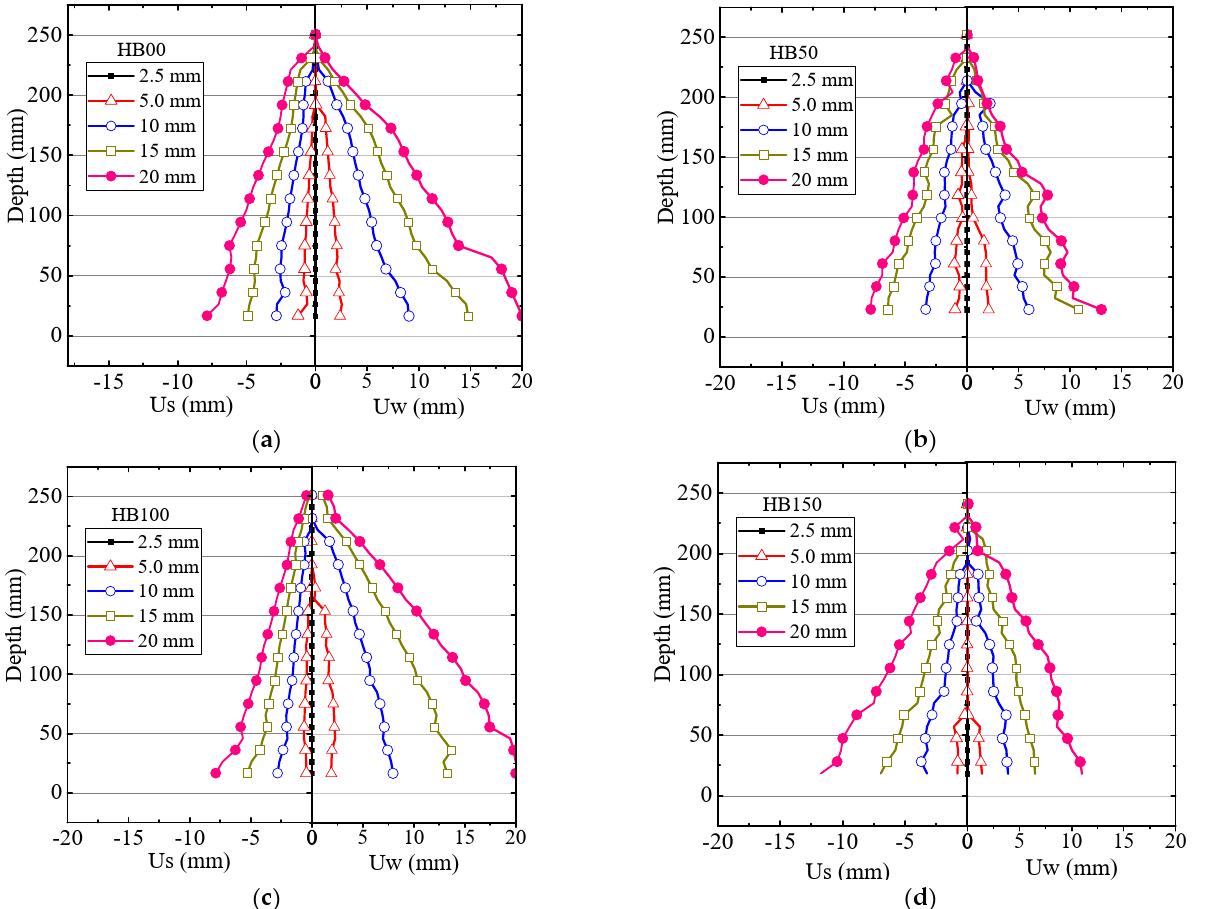
Figure 13. Crack opening ( U w ) and crack slip ( U s ) at different deflection points: ( a ) HB00 beam; ( b ) HB50 beam; ( c ) HB100 beam; ( d ) HB150 beam.